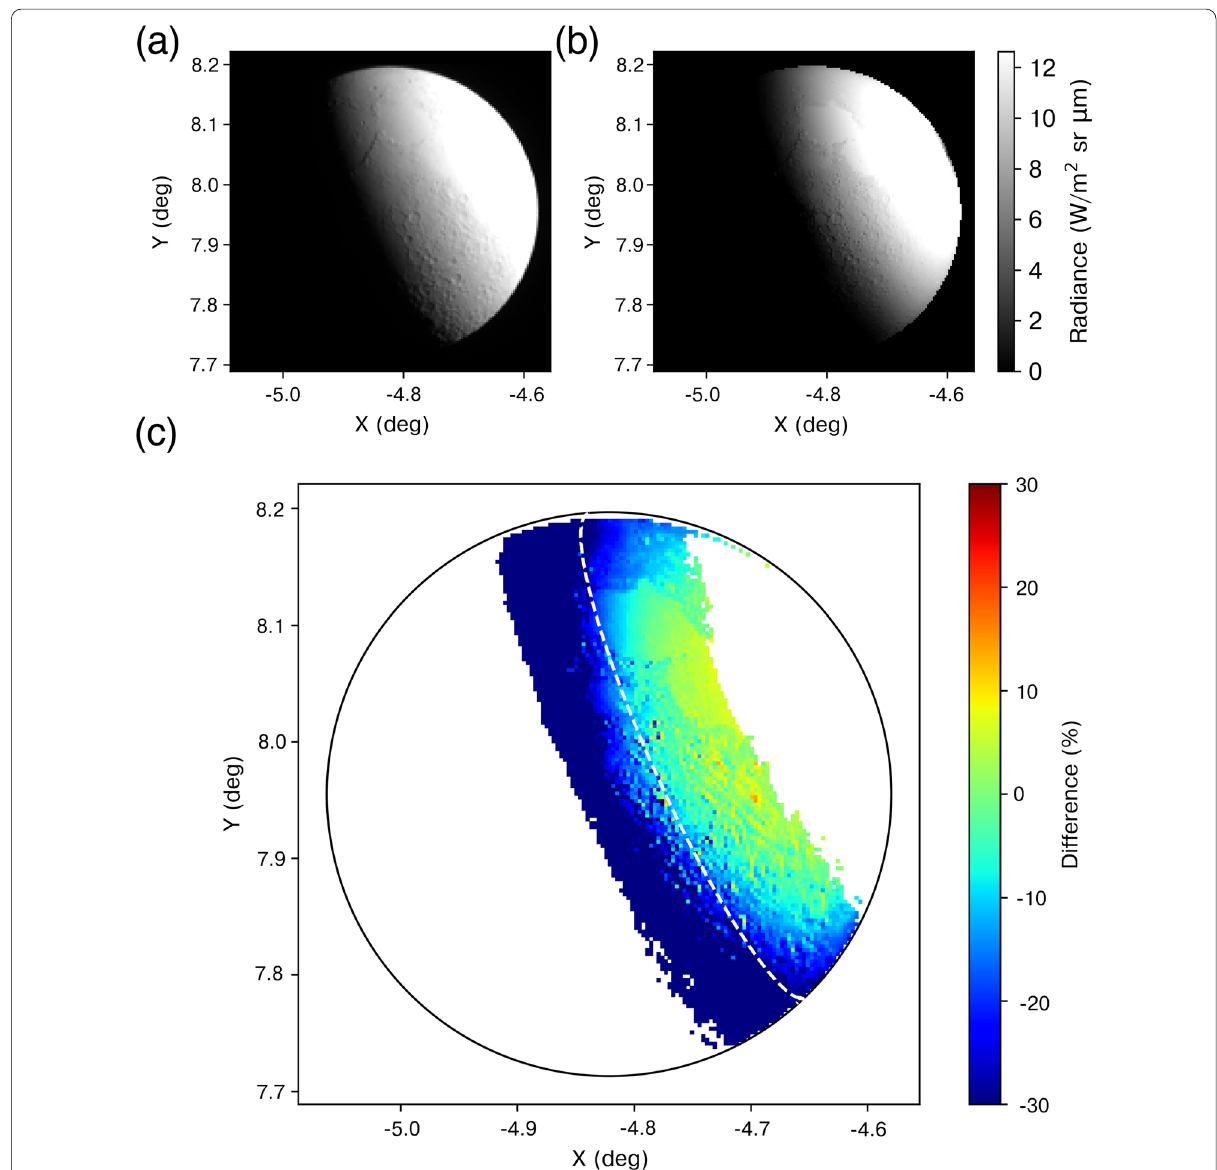
Fig. 8 The lunar images of a observation and b simulation with θ 0 of 18° in band 15 at 2020/05/30 21:10, respectively. c The difference between observation and our simulation in percent. The white area corresponds to space, saturated pixels, or nightside. The white dashed line is located where the incident angle is